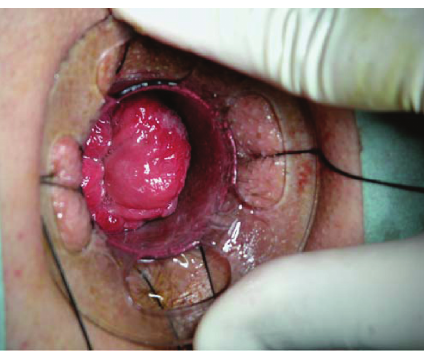
Figure 1: Rectal prolapse exceeding more than half of the length of the Circular Anal Dilator.